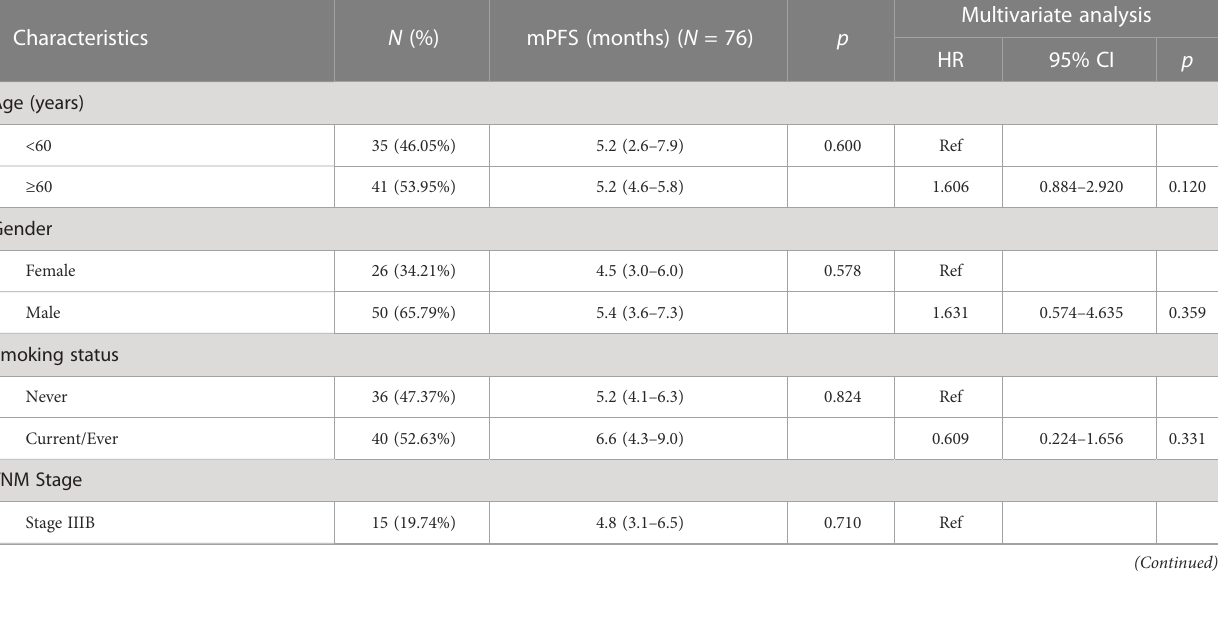
TABLE 2 Univariate and multivariate Cox regression analysis of PFS in 76 advanced NSCLC patients receiving S-1-based non-platinum doublet chemotherapy as a second-line treatment.